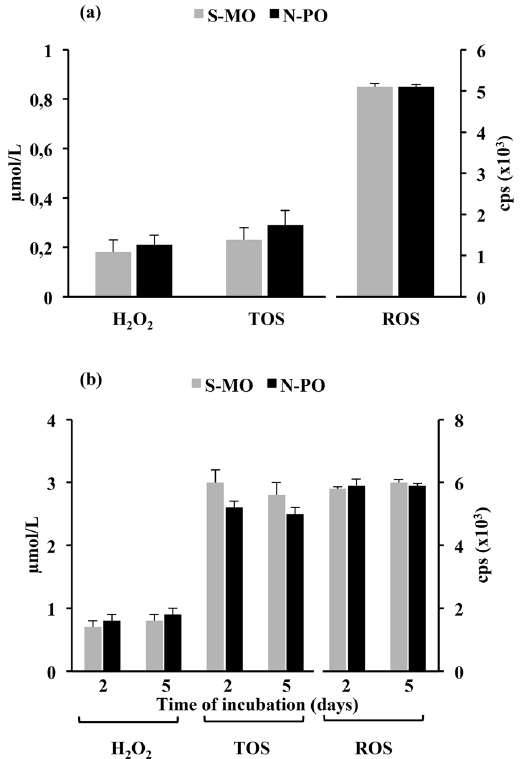
Figure 3. Oxidation values of the culture media incubated under mineral oil and paraffin oil. Drops of IVM or embryo culture medium were covered with Sigma mineral oil (S-MO) or Nidoil paraffin oil (N-PO) and incubated for 1 day (IVM medium) ( a ) or for 2 and 5 days (embryo culture medium) ( b ) under the same conditions used for IVM or embryo culture but without oocytes or embryos. At the end of the incubation, the media were carefully removed and placed in a new Petri dish. This process was repeated three times using a new pipette every time to avoid cross-contamination with the oil. The analysis was performed immediately after sample collection. The media incubated under S-MO and N-PO had similar levels of hydroperoxides, ROS and TOS, regardless of the medium and incubation time used. The data are presented as the mean ± SD (three replicates).